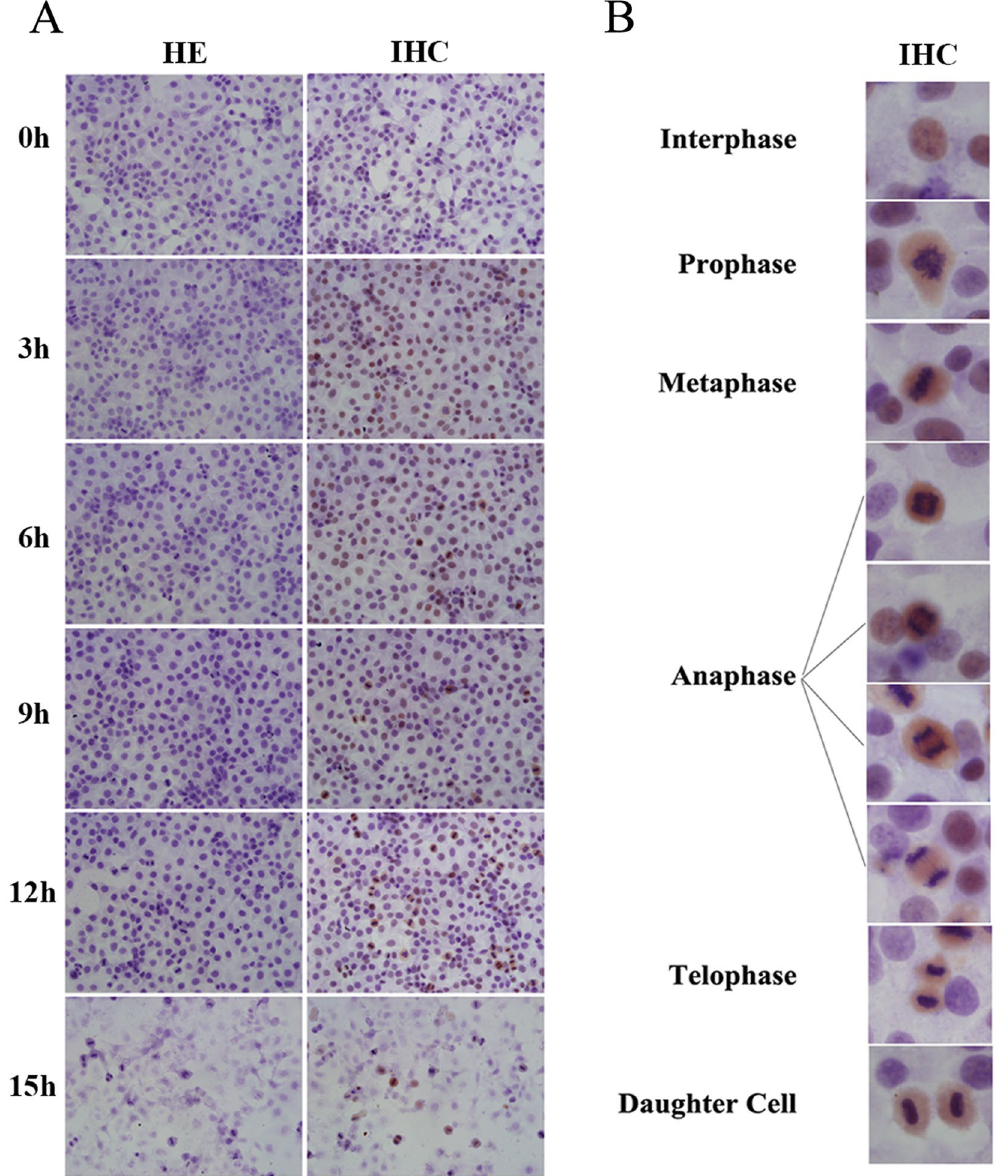
Figure 4. MCM7 proteins highly presents in mitosis phase in HepG2 Cells. ( A ) HepG2 Cells were synchronized by double thymine and then releasing for 0 h, 3 h, 6 h, 9 h, 12 h and 15 h. Western blot analysis of MCM7 (left). Data are expressed as optical density (OD) fold difference related to GAPDH from 3 duplicate experiments (right). N: asynchronized cells. ( B ) and ( C ) Immunohistochemistry analysis of MCM7 in HepG2 Cells. HE: H.E staining, IHC: